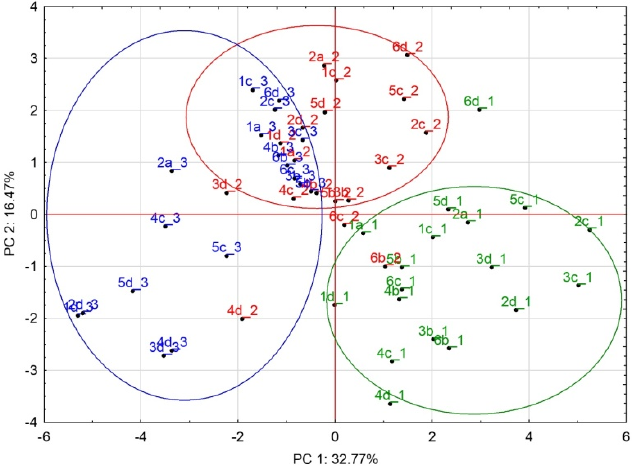
Figure 6. Scatter plot from the principal component analysis (PCA). The analysis included 17 pa- rameters generated from the MDM culture with FBS1 (green, _1), FBS2 (red, _2), or reduced-serum medium (NUS; blue, _3), n = 18.